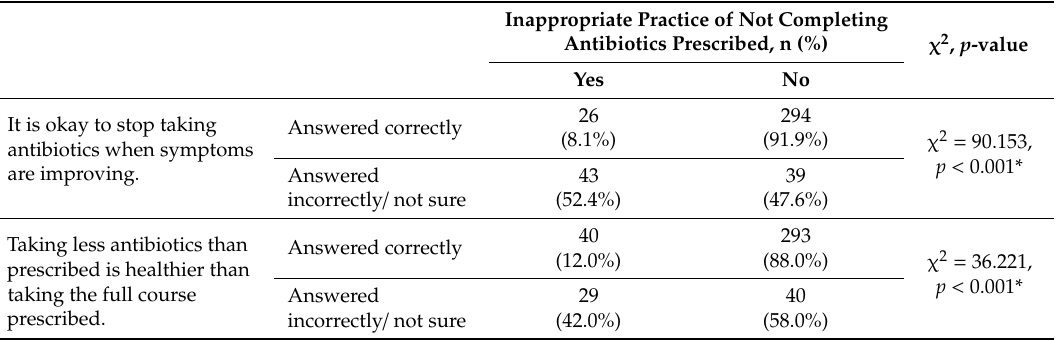
Table 6. Respondents’ knowledge versus their inappropriate practice of not completing antibiotic prescribed (n = 402).